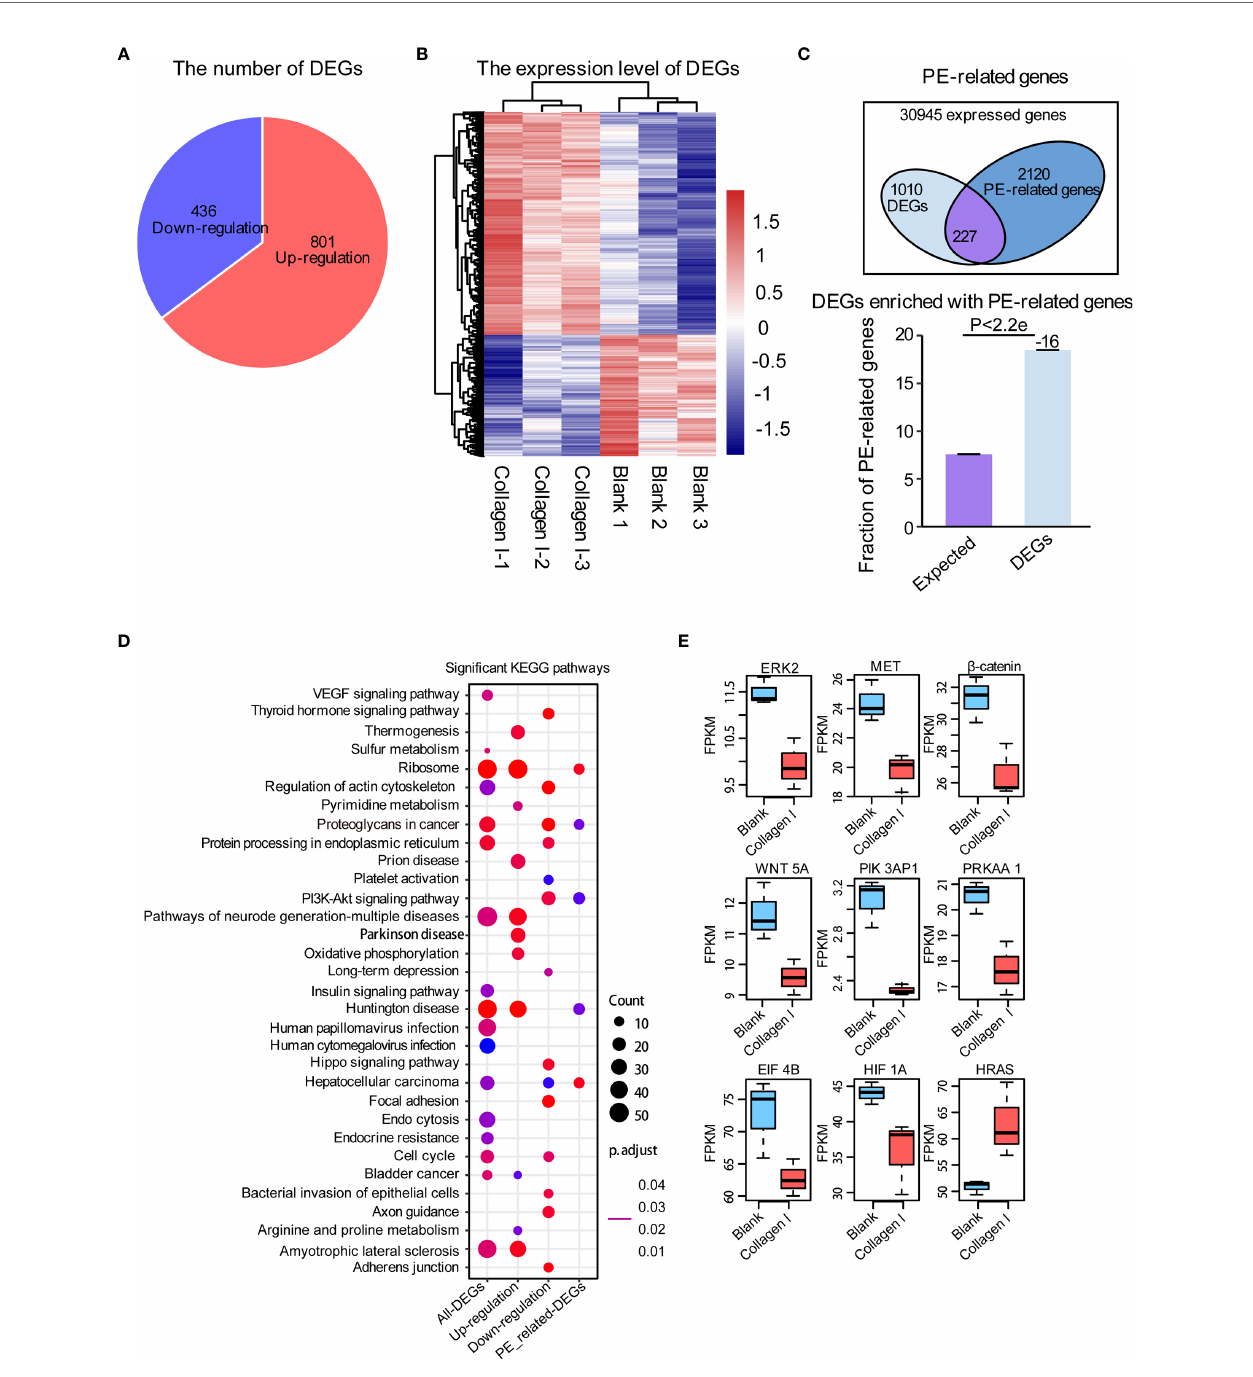
FIGURE 4 | Collagen I induce transcriptional changes in HTR-8SV/neo cells. Overview of differentially expressed genes upon collagen I treatment of HTR-8SV/ neo cells. (A) Pie chart showing the number of differentially expressed genes between collagen I-treated cells and the control group. (B) Heatmap showing the expression levels of differentially expressed genes. (C) Venn diagram showing the PE-related genes expressed in our dataset. Differentially expressed genes were enriched in PE-related genes (p < 0.05). (D) Signi fi cantly enriched KEGG pathways within total differentially expressed genes, including upregulated genes, downregulated genes, and differentially expressed PE-related genes. (E) Boxplots showing the relative expression levels of ERK2 (MAPK1) , MET , b -catenin, WNT5A , PIK3AP1 , PRKAA1 , EIF4B , HIF1A , and EIF4B . Enrichment analyses were performed on the R platform, and two-tailed Fisher ’ s exact test was used. Error bars represent the standard error of the fraction, estimated using a bootstrapping method with 100 re-samplings. The data of the experimental validations are presented as mean ± standard error of mean (SEM) of two independent experiments. Comparisons between two independent groups were conducted using Student ’ s t